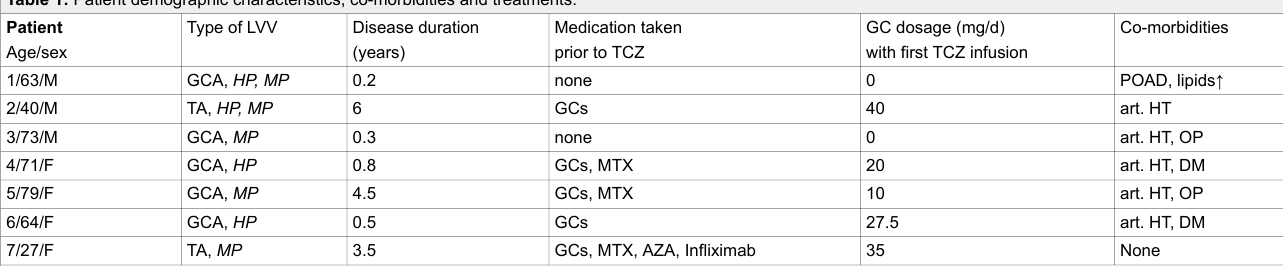
Table 1: Patient demographic characteristics, co-morbidities and treatments. Patient Type of LVV Age/sex